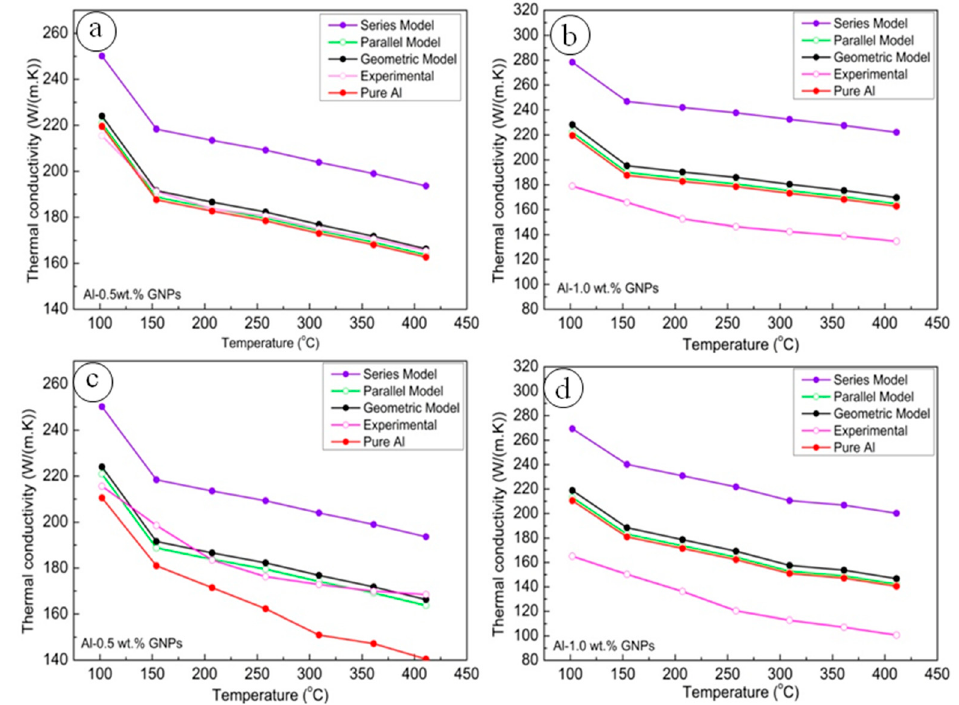
Figure 11. The thermal conductivity of Al/GNPs nanocomposites produced by ( a , b ) press-sintering process, ( c , d ) hot rolling [131], Reproduced from [131], with permission from Springer Nature, 2017.